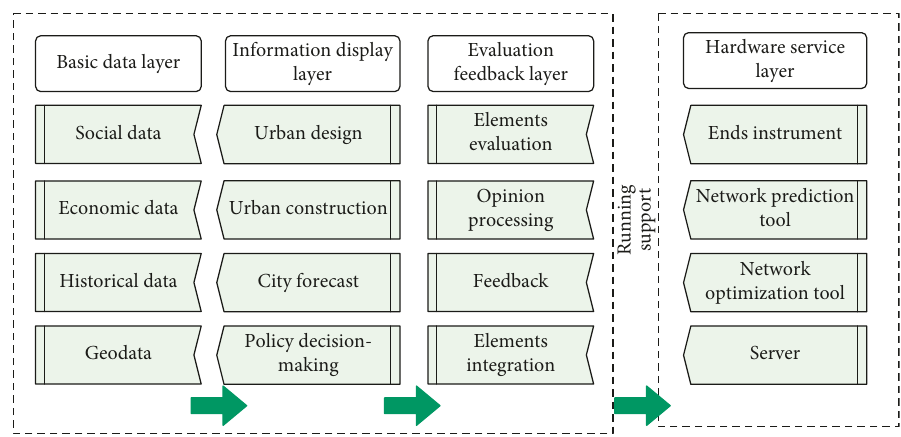
Figure 3: Intelligent platform development model.